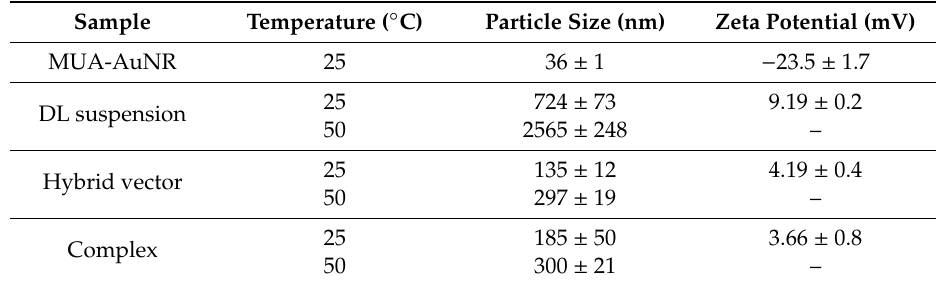
Figure 2. Atomic force microscopic (AFM) images for ( a ) dendron lipid suspension (EDEG-DL/DL = 9/1, mol/mol), ( b ) MUA-AuNR, ( c ) hybrid vector (Au/lipid = 9/10, mol/mol) and ( d ) complex (L/P = 48). Transmission electron microscopic (TEM) images for ( e ) MUA-AuNR, ( f ) hybrid vector, and ( g ) complex. ( h ) Absorption spectra for MUA-AuNR, hybrid vector and complex. ( i ) Heat generation of DMEM suspension for MUA-AuNR, hybrid vector and complex under NIR laser irradiation as a function of the laser irradiation time. ( j ) Transmittance for dendron lipid suspension, MUA-AuNR, hybrid vector and complex as a function of temperature. Table 1. Particle sizes and zeta potentials of MUA-AuNR, DL suspension, hybrid vector and complex (L/P = 48).